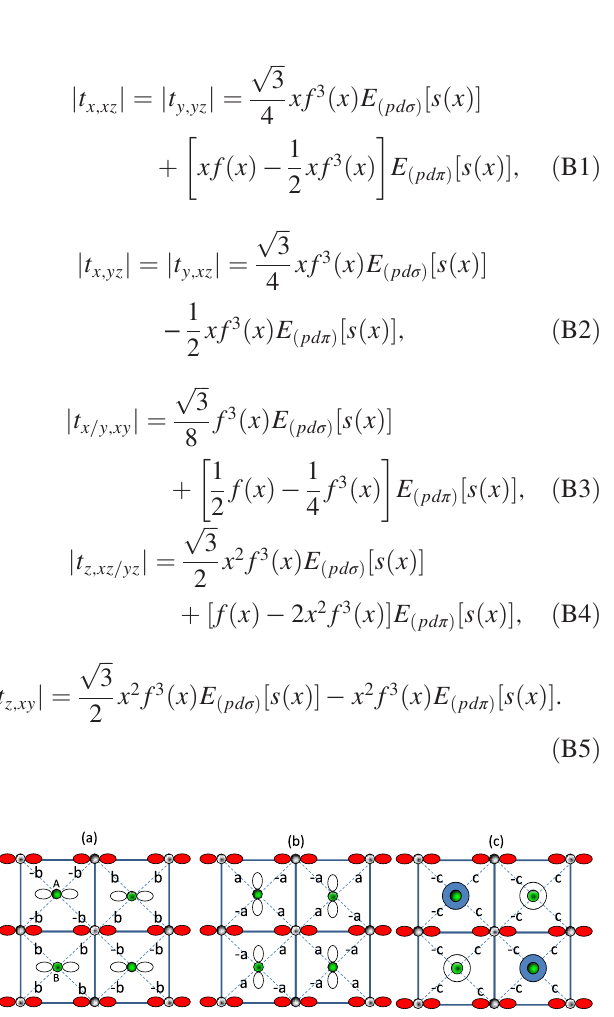
− p couplings. Here, a ¼ j t FIG. 7. The pattern of d xz b ¼ j t , c ¼ j t . x;xz j z;xz j